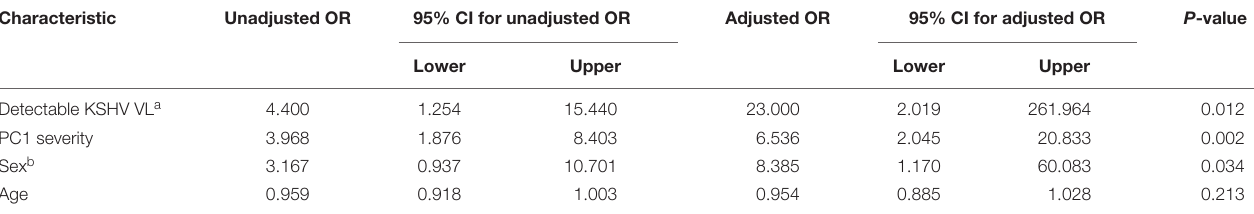
TABLE 5 | Logistic regression for death outcome in HIV negative COVID positive patients ( n = 73). Characteristic Unadjusted OR 95% CI for unadjusted OR Adjusted OR 95% CI for adjusted OR P -value Lower Upper Lower